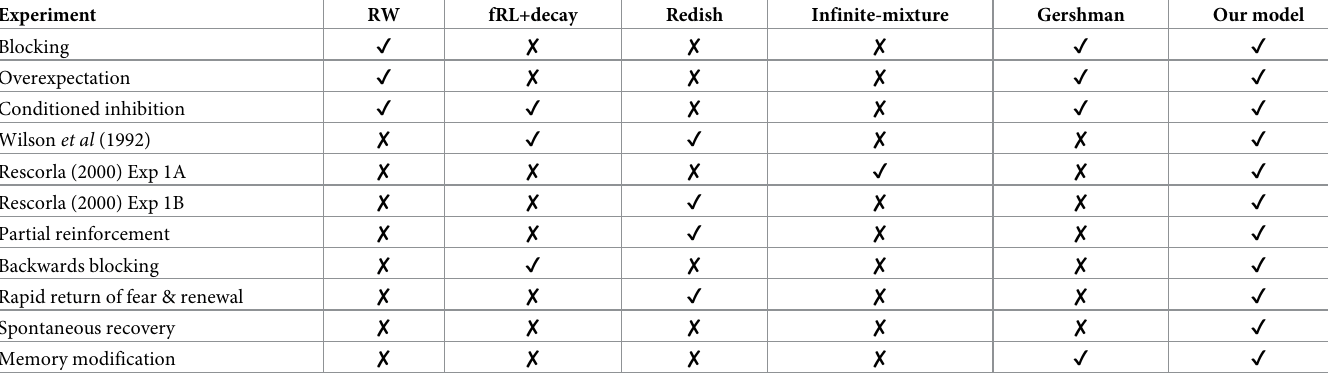
Table 2. Models were assessed based on whether or not they could reproduce the observed effect for each simulated experiment (yes = ✔ or no = ✘ ), with observed effects defined in Table 1. It is important to note, however, that this assessment does not account for the magnitude of the effect or whether a different set of parameters could reproduce the effect. RW fRL+decay Redish Infinite-mixture Gershman Our